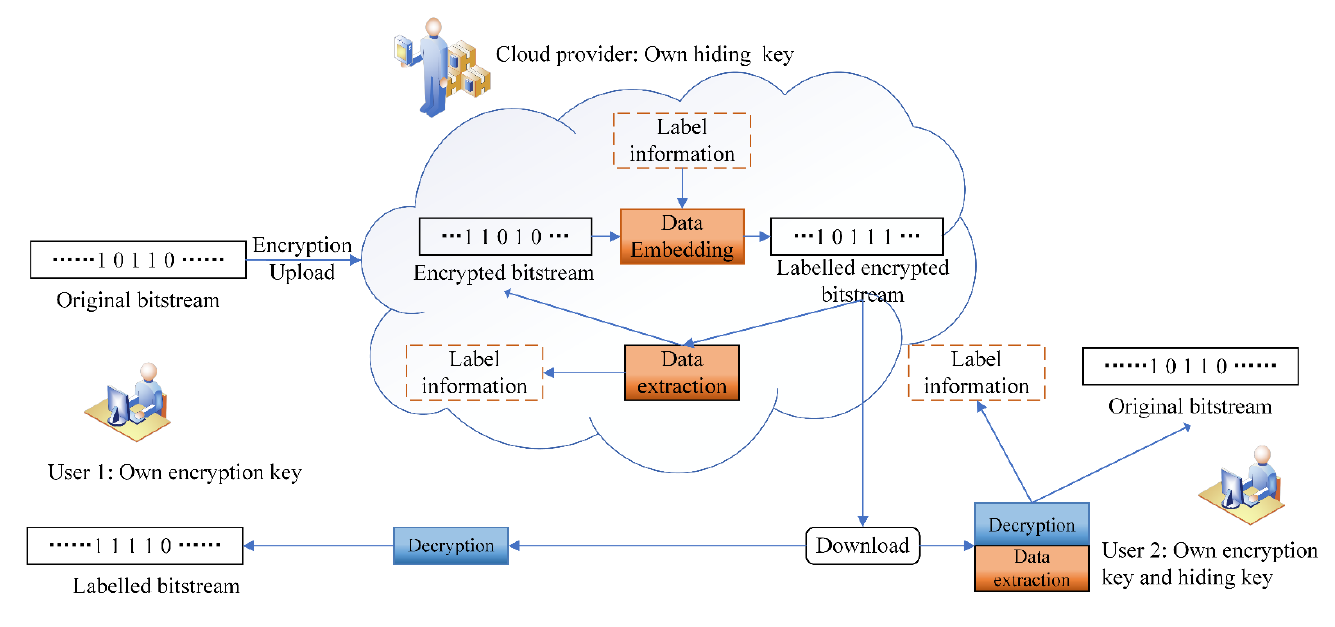
Figure 7. Application scenarios in cloud environment.